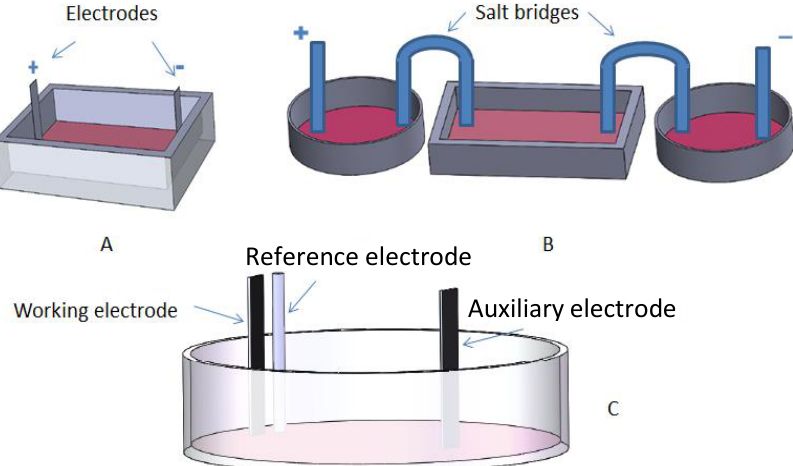
Figure 1. ( A ) EF between two electrodes immersed in cell culture, in which the electrodes may take different forms such as L and against the bottom to make the EF more uniform; ( B ) Using salt bridges between electrodes to avoid the diffusion of electrochemical reaction products into culture medium; ( C ) Working electrodes as a cell culture substrate in a three-electrode system, where the working electrode can be a metal, a glass slide coated with indium tin oxide, or a conducting polymer.